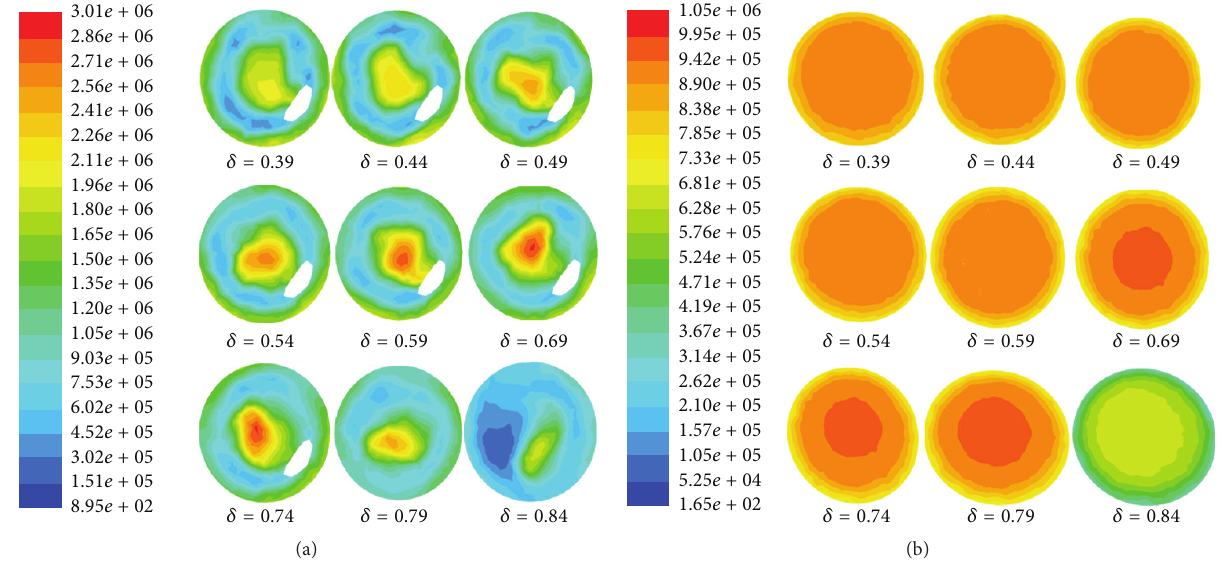
Figure 18: Contour plots evaluation of wave dynamic pressure (Pascal) field (a) in Shchelkin spiral and (b) without Shchelkin spiral in detonation tube at Ma = 1.4